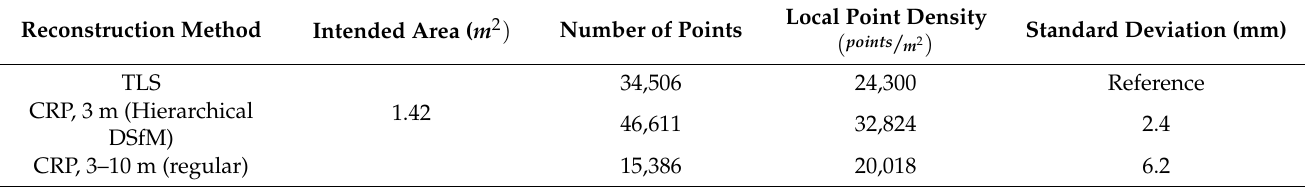
Table 7. Resolution level of CRP generated using both methods compared to TLS data.